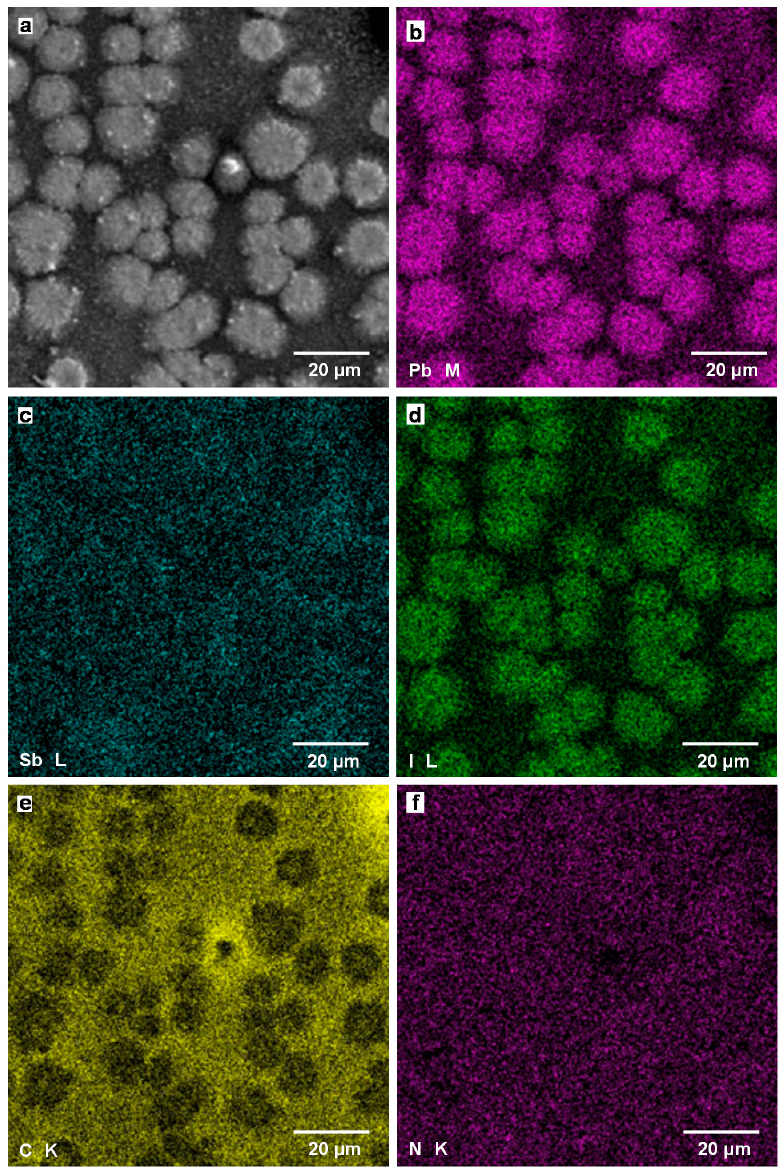
Figure 7. ( a ) SEM image of CH 3 NH 3 Pb(Sb)I 3 (Cl) cell with an additive of SbI 3 . Elemental mapping images of ( b ) Pb M line, ( c ) Sb L line, ( d ) I L line, ( e ) C K line, and ( f ) N K line.